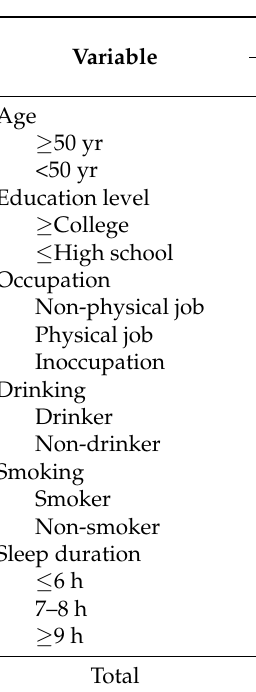
Table 2. General characteristics of